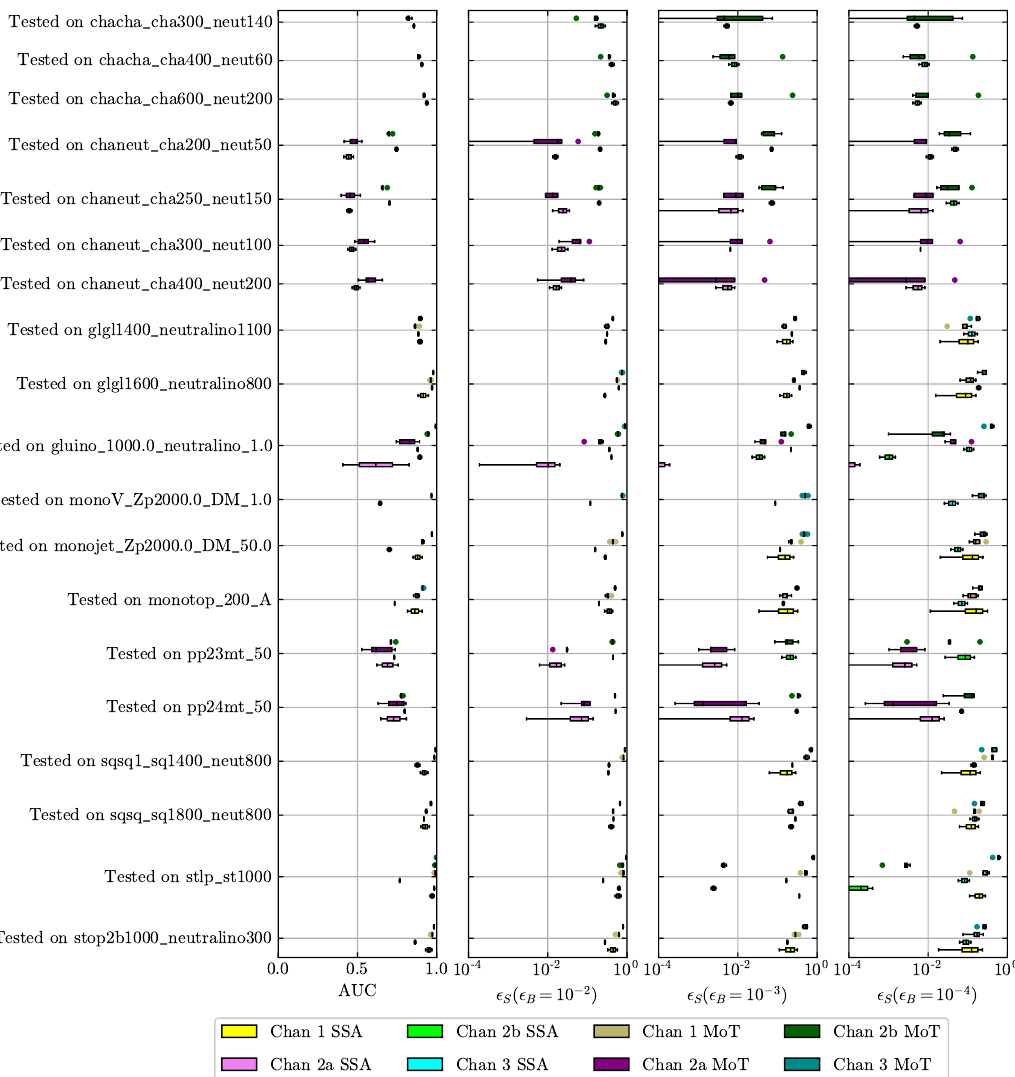
Figure 8 . The figure shows the results for AUC and (cid:15) S with several (cid:15) B ( 10 − 2 , 10 − 3 and 10 − 4 ) tested with signals from the hackathon data . This compares the supervised methods trained with a mixture of theories (boxes above the middle lines) to those trained with a single signal approach (boxes below the middle lines). Chan X SSA means the results for channel X from the single signal approach. Chan X MoT means the results for channel X from a mixture of theories. SSA contains two ML models corresponding to the endpoints of the solid lines in figure 1, 5, 6 and 7, while MoT contains 5 ML models corresponding to the points on the dashed lines that have the same event number as the endpoints of the solid